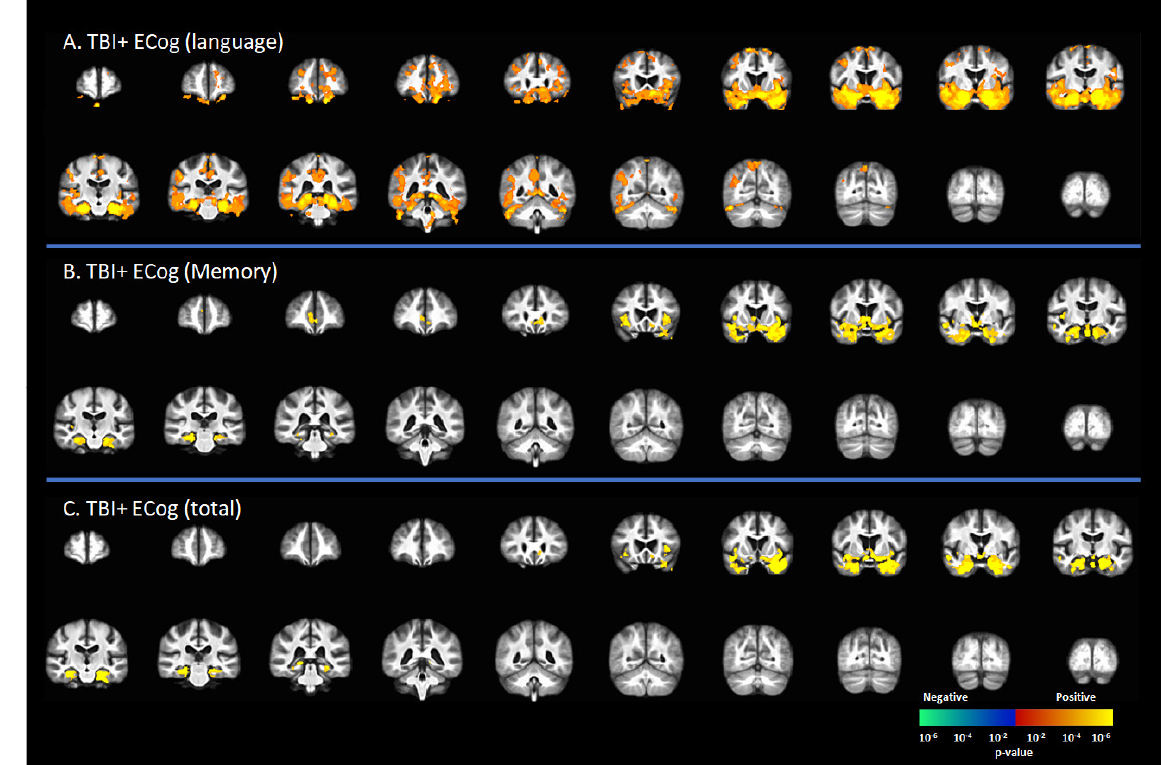
Figure 2. Correlation between [ 18 F]-AV1451 SUVr maps and everyday cognition (ECog) scores in the population with a self-reported history of traumatic brain injury (TBI), with results of the correlations between tau deposition and ( A ) ECog-Language sub-test, ( B ) ECog-Memory sub-test, and ( C ) ECog-total score. Red-yellow represents a positive correlation between tau accumulation in people with self-reported history of TBI and ECog scores, while blue-green represents negative correlation between tau accumulation and ECog score.